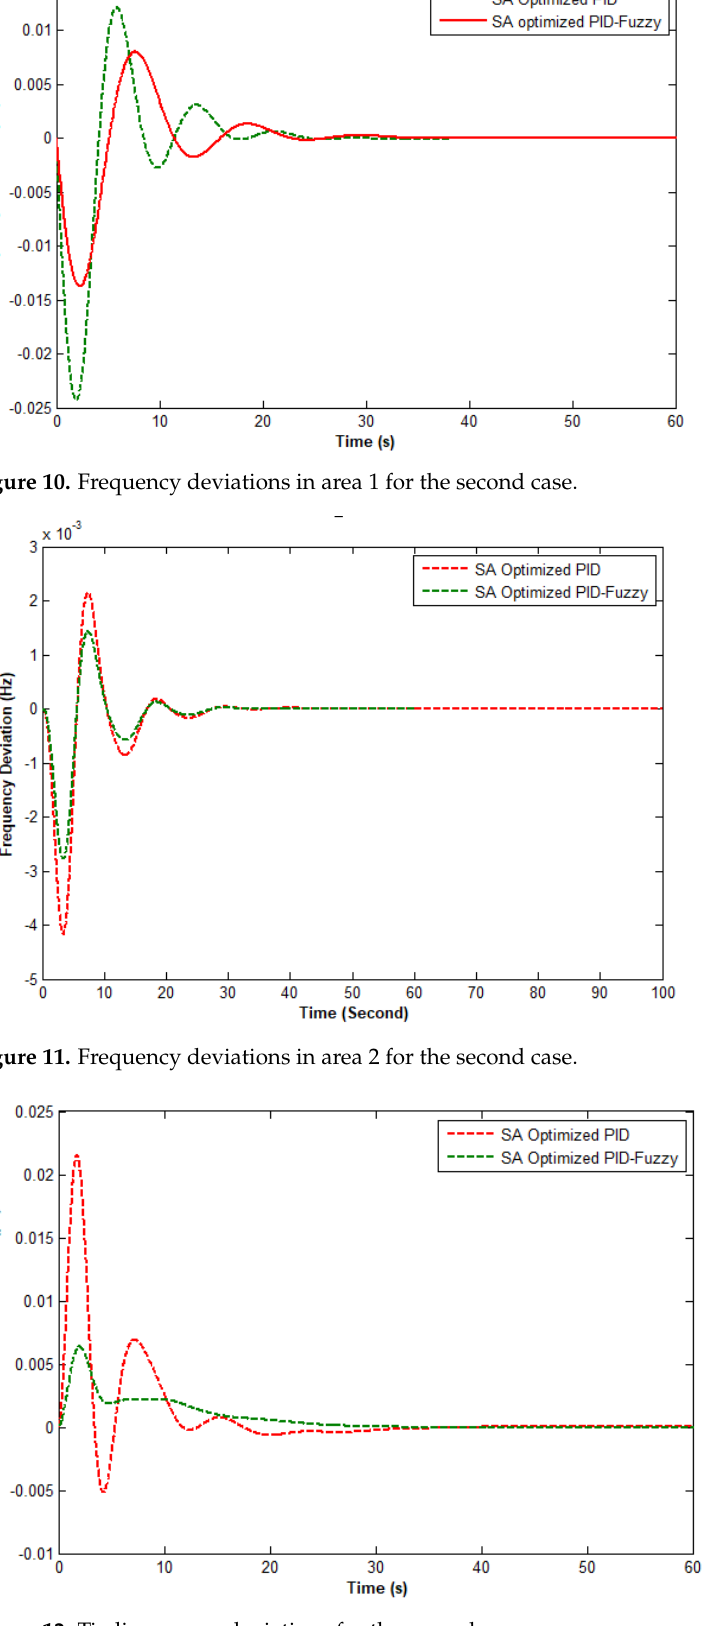
Figure 12. Tie-line power deviations for the second